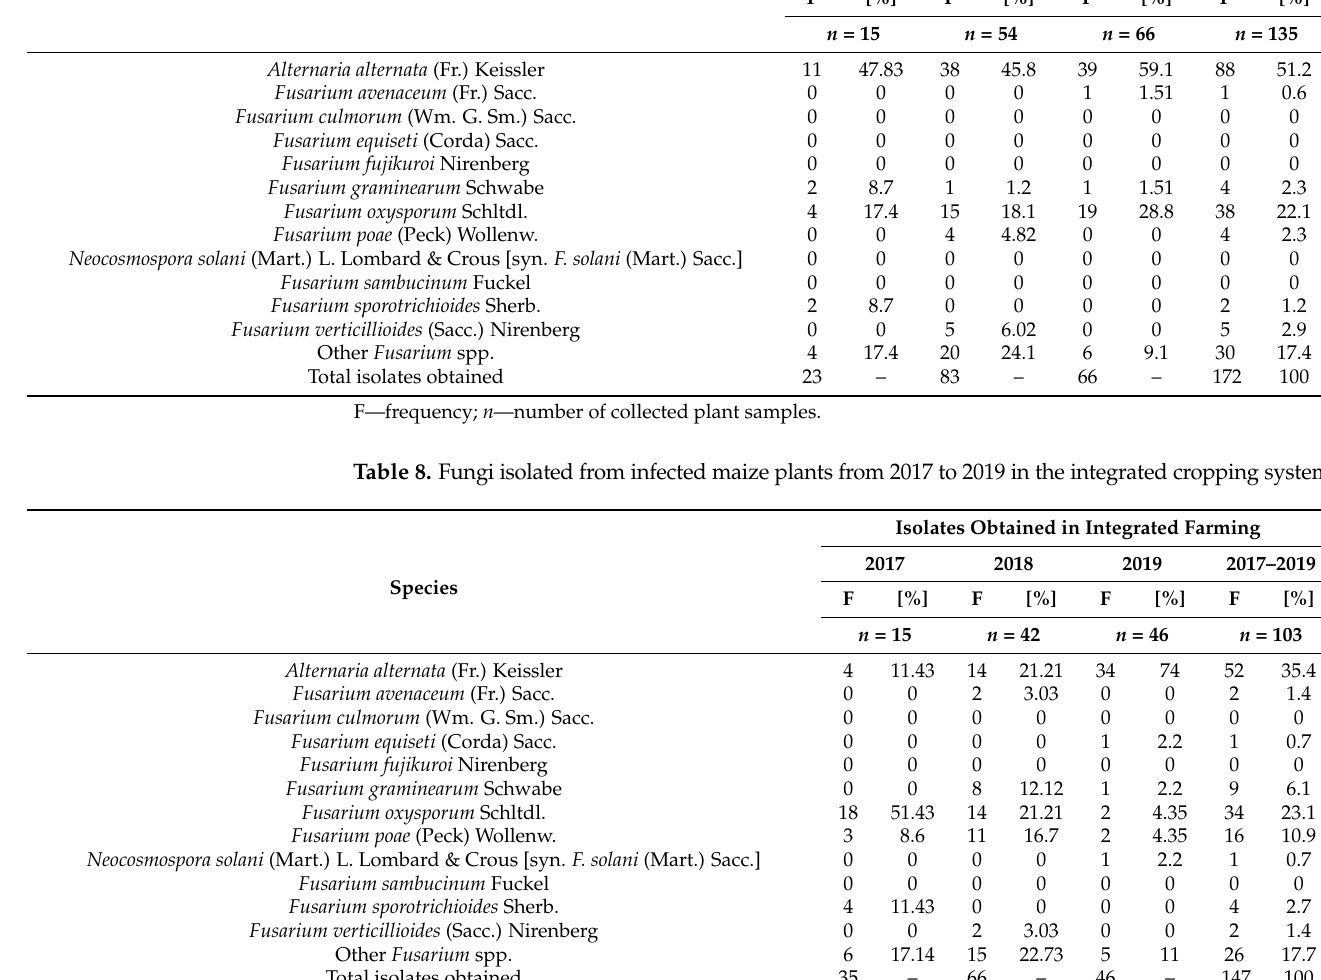
Table 7. Fungi isolated from infected maize plants from 2017 to 2019 in the organic cropping system. Species